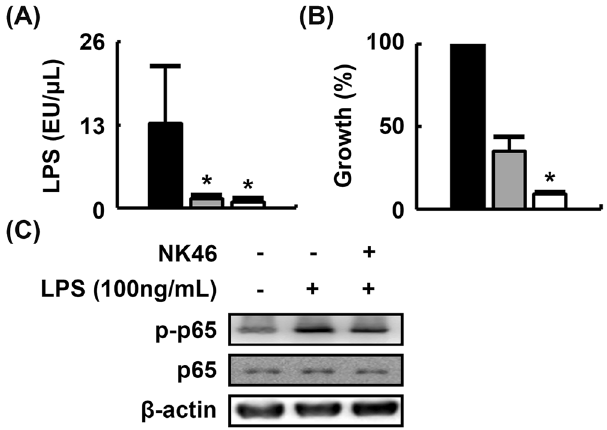
Figure 1. NK46 inhibited LPS production in mouse gut microbiota and NF- κ B activation in LPS-stimulated microglial BV-2 cells. ( A ) Effect on LPS production. ( B ) Effect on fecal bacteria growth. Fecal bacterial cells (1 × 10 5 colony forming unit [CFU]/mL) were anaerobically incubated in 10 mL of general anaerobic medium (GAM) broth with NK46 (black, vehicle alone; gray, 1 × 10 5 CFU; white, 1 × 10 6 CFU/mL) for 24 h. Number of fecal bacteria were counted in the GAM agar plate. ( C ) Effect on LPS-induced NF- κ B activation in BV-2 cells. BV-2 cells (5 × 10 5 cells/mL) were incubated with LPS in the absence or presence of NK46 (1 × 10 5 CFU/mL). All data were expressed as mean ± SD (n = 4). * p < 0.05 vs. control group treated with vehicle